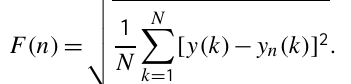
October 22, 1993 in ACA1. b) SES activity in September 12, 1995 (ACA2).